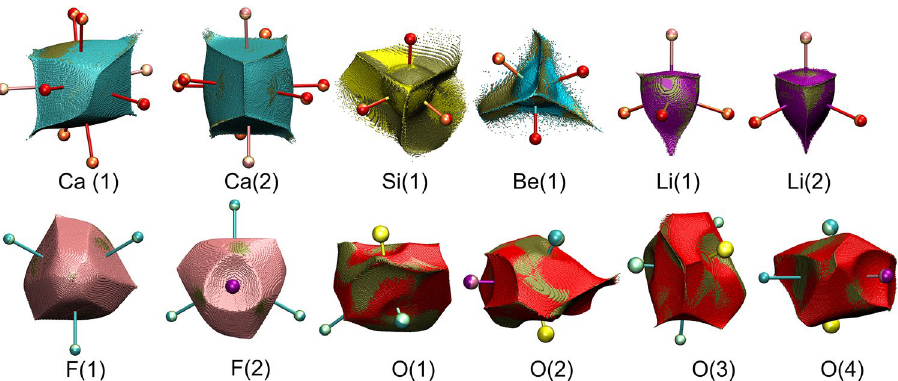
Figure 3. Projections of ionic basins at 4.2GPa (in green) onto ionic basins of the same ions at 1.9 GPa (various colours). Green spots on top indicate the expansion of this fragment of the ion under